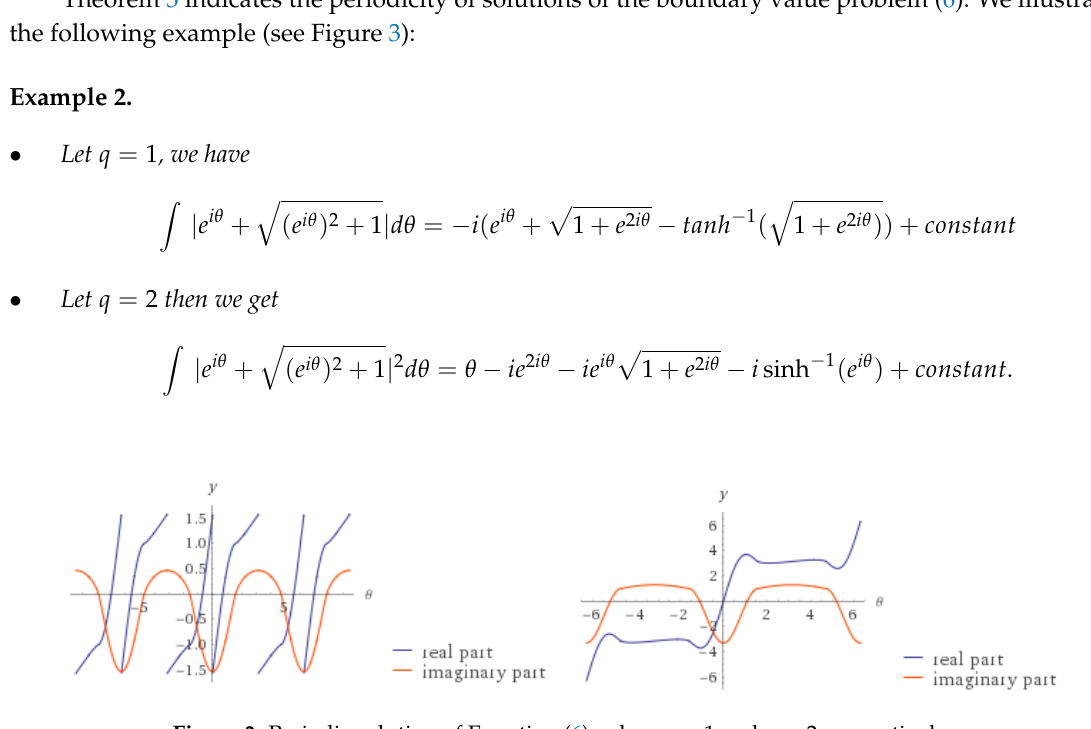
Figure 3. Periodic solution of Equation (6), when q = 1 and q = 2,